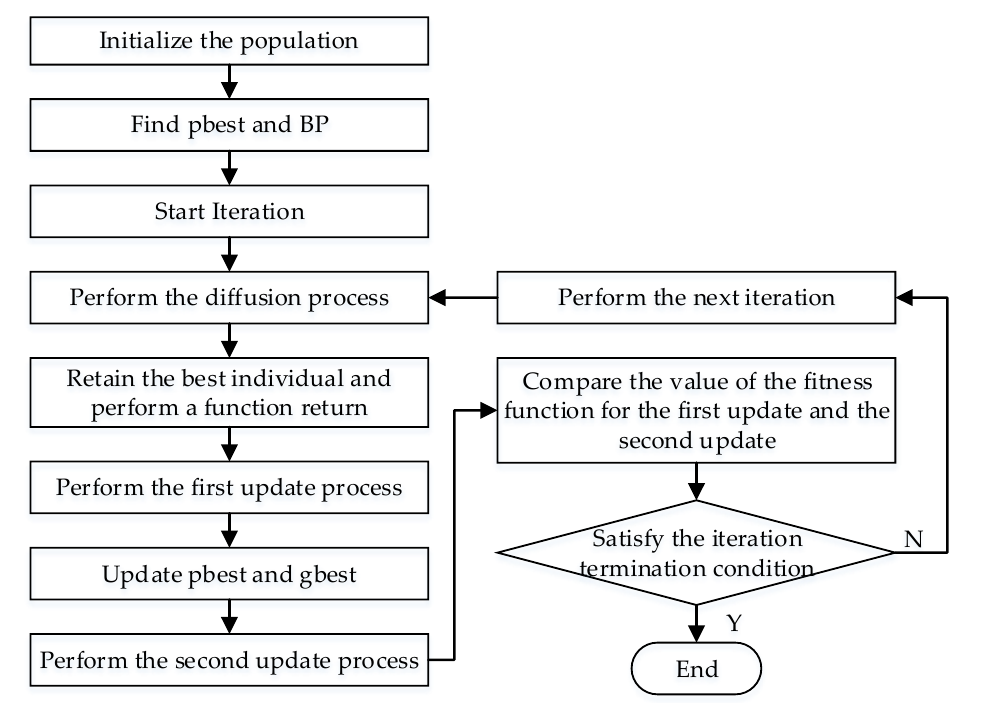
Figure 1. The flowchart of the ISFS algorithm.